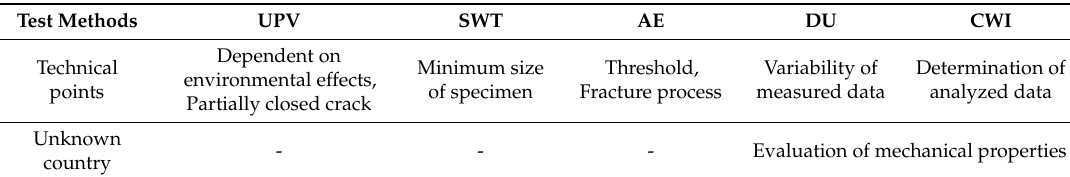
Table 7. Limitations of ultrasonic wave methods for self-healing